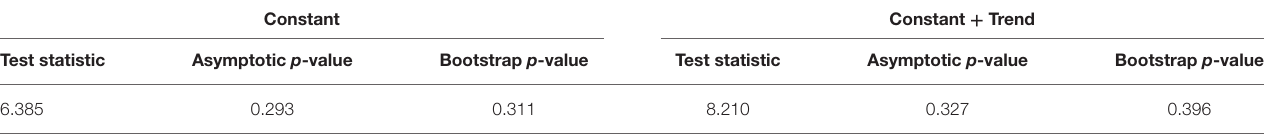
TABLE 5 | Westerlund and Edgerton (46) bootstrap cointegration test.